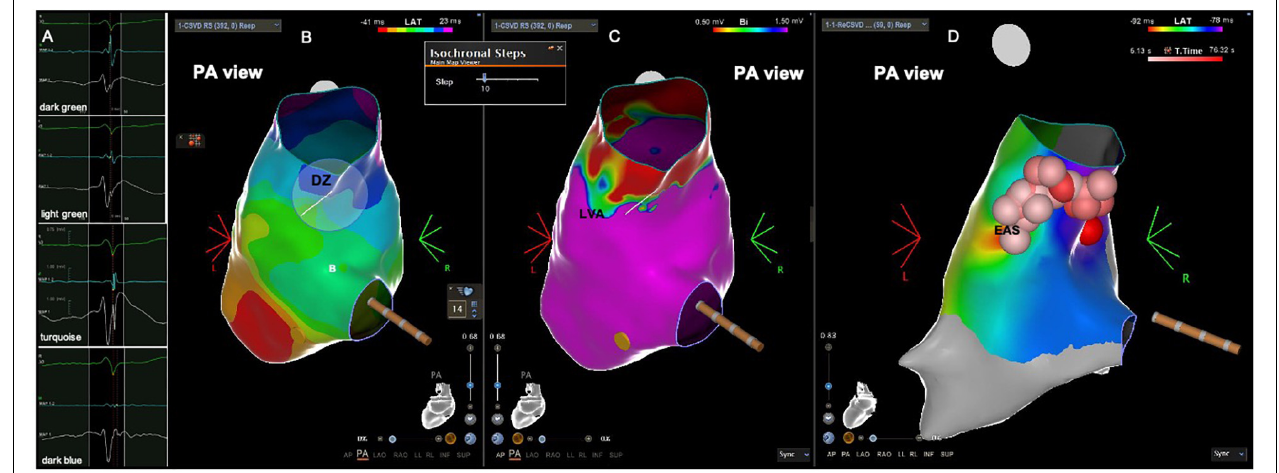
FIGURE 7 | Patient from the PVC group with DZ at a LVA and the earliest activation site located in that zone. (A) Intracardiac electrograms corresponding to the respective isochrones presented in the isochronal map. (B) RVOT isochronal map in sinus rhythm with DZ in the RVOT posterior wall. (C) Voltage map in sinus rhythm with LVA in the RVOT posterior wall. (D) Activation map during PVC showing the EAS at the DZ and LVA. Red and pink balls corresponding to radiofrequency application points. DZ, deceleration zone; EAS, earliest activation site; LVA, low voltage area; PVC, premature ventricular contractions; RVOT, right ventricular outflow tract.